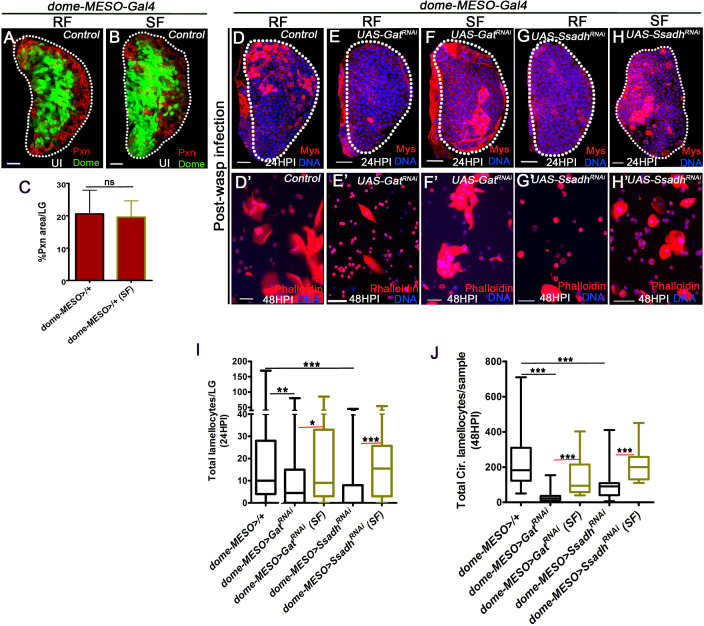
GABA-shunt-derived succinate controls lamellocyte potential.DNA is marked with DAPI (blue) and blood cells are marked with phalloidin (red). In panels (A, B, D-H, scale bars = 20 µm and D’–H’) = 50 µm. HPI indicates hours post wasp-infection, RF is regular food and SF is succinate food. In lymph gland, lamellocytes analyzed at 24HPI and in circulation at 48HPI. Graph in panel (C) Represents mean + standard deviation (mean + SD) and in panels (I and J) Median is shown in box plots and vertical bars represent upper- and lower cell counts. Statistical analysis in panel (C) is unpaired t-test, two-tailed and in panels (I and J) is Mann-Whitney, two-tailed. ‘n’ is the total number of larvae analyzed, and for lymph glands ‘n’ represents lymph gland lobes analyzed. ns is nonsignificant. For better representation of the lymph gland primary lobes, the images shown have been edited for removal of adjacent tissues (like dorsal vessel and ring gland). (A–C) Progenitor maintenance (Domeless, green) and differentiation status (Peroxidasin, Pxn, red) is unaffected with (B) succinate supplementation (5% SF) as compared to (A) regular food (RF) condition in control (dome-MESO-Gal4, UAS-GFP/+). (C) Quantification of dome-MESO-Gal4, UAS-GFP/+on RF (n = 15) and SF (n = 11, ns) represented as percentage area distribution of Peroxidasin (Pxn, differentiation status) in 3rd instar larval lymph gland, also refer Supplementary file 3. (d–h’) Compared to lamellocytes detected in (D, D’) control (dome-MESO-Gal4, UAS-GFP/+) (D) lymph gland and (D’) circulation, their formation is affected in (E–E’) dome-MESO-Gal4, UAS-GFP; UAS-GatRNAi (on RF). This is restored by (F, F’) succinate supplementation both in the (F) lymph gland (compared with E) and (F’) circulation (compared with E’). Similarly, lamellocytes formation is affected in (G–G’) dome-MESO-Gal4, UAS-GFP; UAS-SsadhRNAi (on RF), which is restored by (H, H’) succinate supplementation in the (H) lymph gland (compared with G) and (H’) circulation (compared with G’). Corresponding quantifications are shown in (I and J). (I) Total lamellocyte quantification per lymph gland. dome-MESO-Gal4, UAS-GFP/+ on RF (control, n = 115), dome-MESO-Gal4, UAS-GFP; UAS-GatRNAi on RF (n = 60, **p=0.0027), dome-MESO-Gal4, UAS-GFP; UAS-GatRNAi on SF (n = 53, *p=0.0235), dome-MESO-Gal4, UAS-GFP; UAS-SsadhRNAi on RF (n = 63, ***p<0.0001) and, dome-MESO-Gal4, UAS-GFP; UAS-SsadhRNAi on SF (n = 36, ***p<0.0001). (J) Total circulating lamellocyte quantification per sample. dome-MESO-Gal4, UAS-GFP/+ on RF (control, n = 46), dome-MESO-Gal4, UAS-GFP; UAS-GatRNAi on RF (n = 26, ***p<0.0001), dome-MESO-Gal4, UAS-GFP; UAS-GatRNAi on SF (n = 12, ***p<0.0001), dome-MESO-Gal4, UAS-GFP; UAS-SsadhRNAi on RF (n = 22, ***p<0.0001) and, dome-MESO-Gal4, UAS-GFP; UAS-SsadhRNAi on SF (n = 13, ***p<0.0001).Figure 2—figure supplement 4—source data 1.Contains numerical data plotted in Figure 2—figure supplement 4C,I and J.